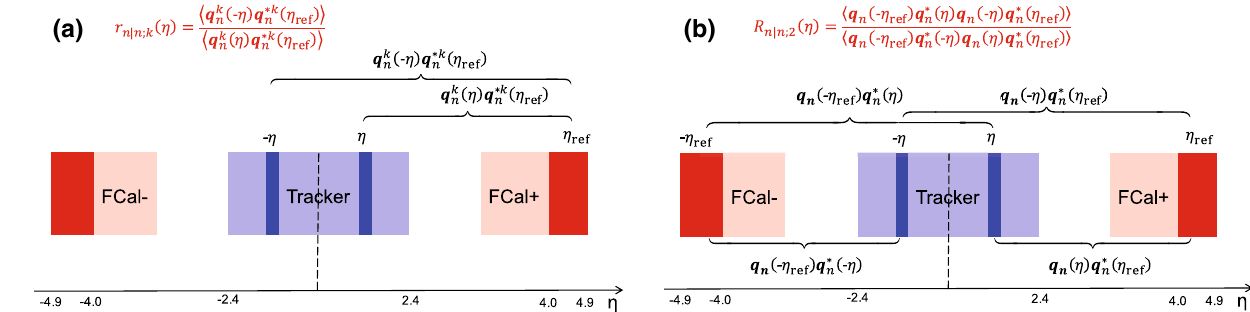
Fig. 1 Schematic illustration of the procedure for constructing the corrlators r n | n ; k (η) Eq. (2) (left panel) and R n | n ; 2 (η) Eq. (5) (right panel). The acceptance coverages for the ATLAS tracker used for η and reference detector used for η ref are discussed in Sect.